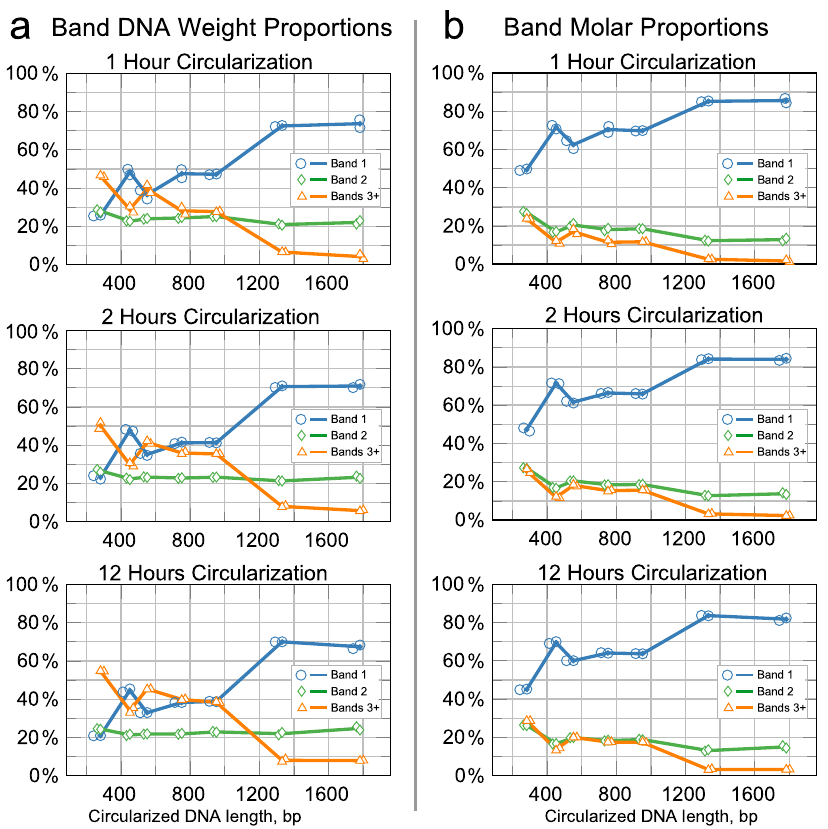
Fig. 3 Characterization of the circularization product by ImageJ gel electrophoresis band brightness analysis. We show the fi rst, second, and the sum of third and higher bands corresponding to single, doubled, and the sum of the higher-order concatemers. The line nodes represent the averages of n = 2 independent reaction samples calculated from the gel electrophoresis band brightness; the dots show individual data samples for the nodes, horizontally offset for visibility. a Relative DNA weight is equal to relative band brightness. b Relative band molar count is counted as relative band brightness divided by band number (see also Eq.